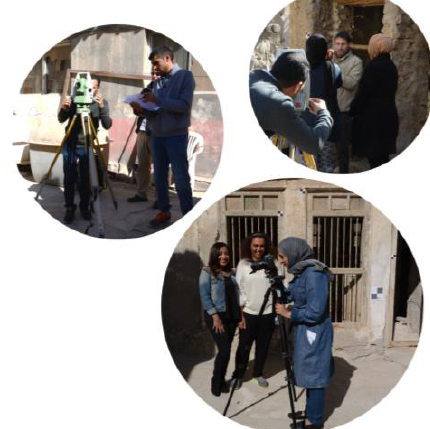
Figure 7 BACA participants during the documentation